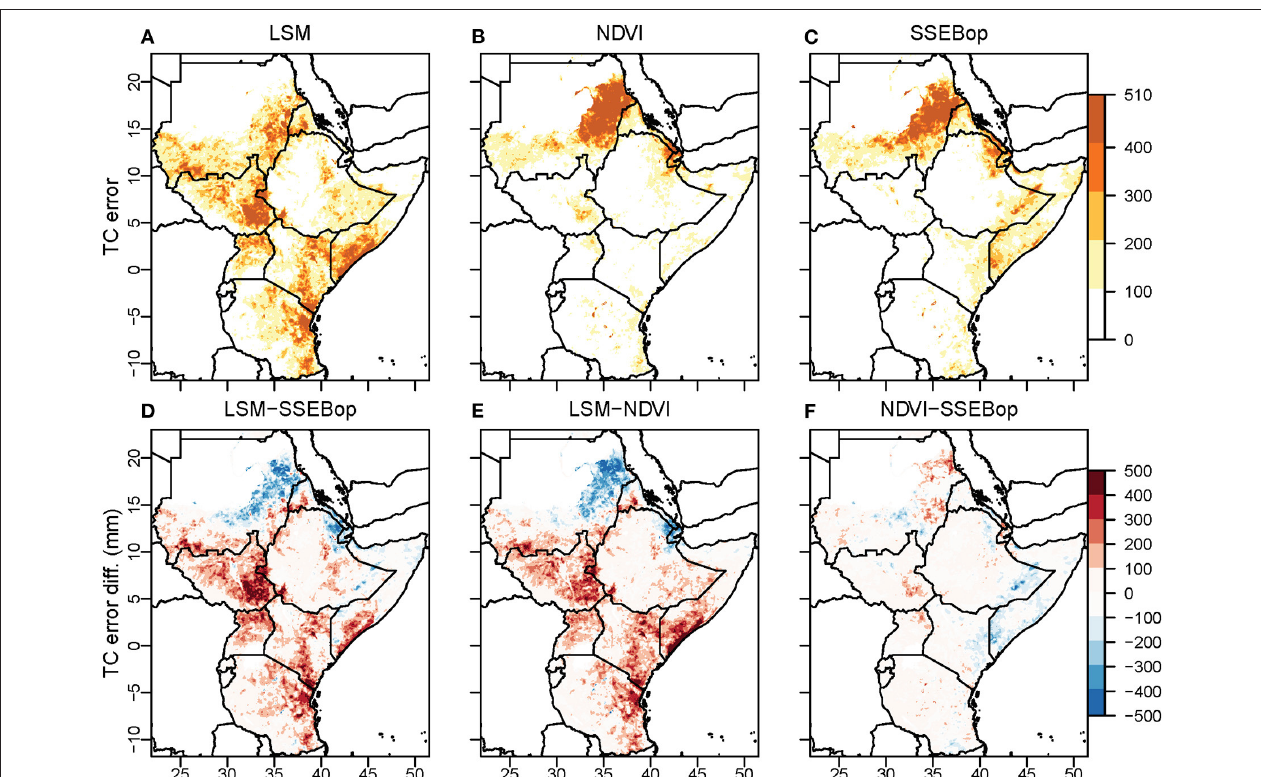
FIGURE 6 | Triple Collocation (TC) error estimates (in mm) over the 2003–2016 for (A) LSM ET, (B) NDVI, and (C) SSEBop ET. LSM ET and NDVI have been rescaled to SSEBop ET. The difference in TC error between (D) LSM ET and SSEBop ET, (E) LSM ET and NDVI, (F) SSEBop ET and